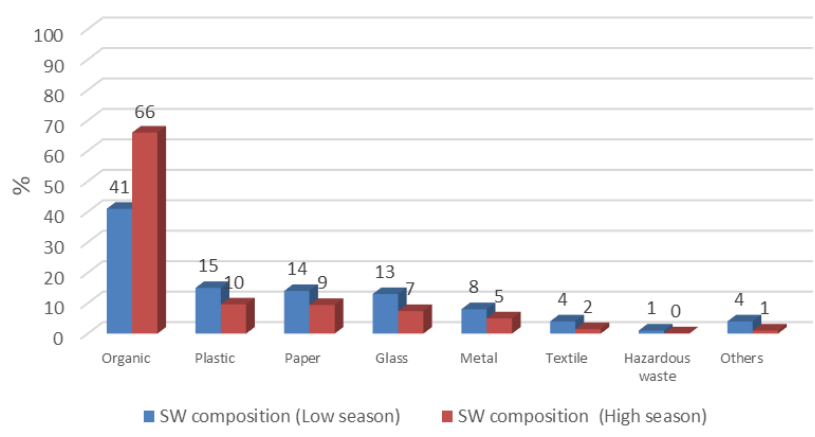
Figure 2. SW characteristics comparison in Gammarth between low and high seasons.